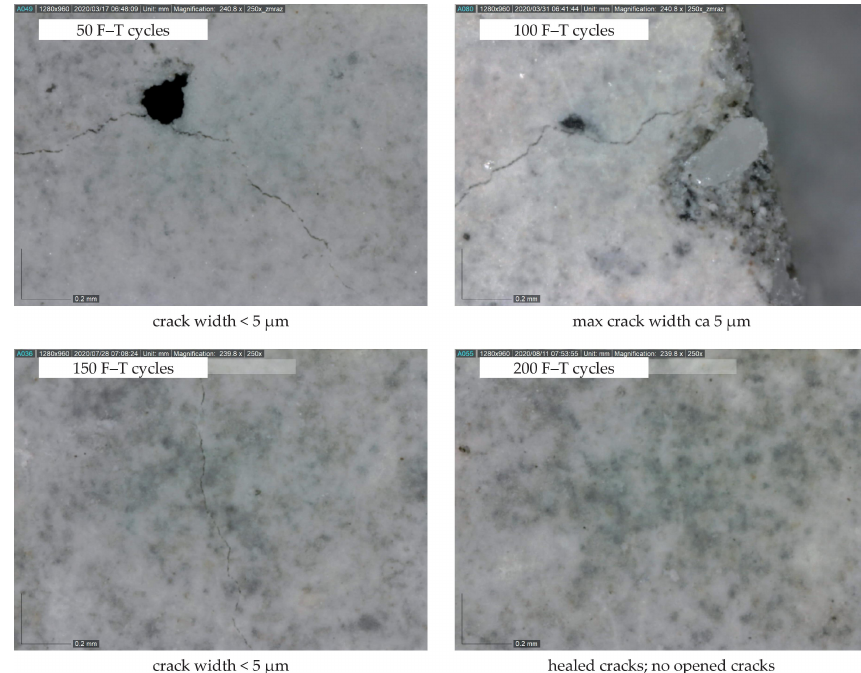
Figure 7. Microcracks on the specimen surface (C1; magnification 250 ×